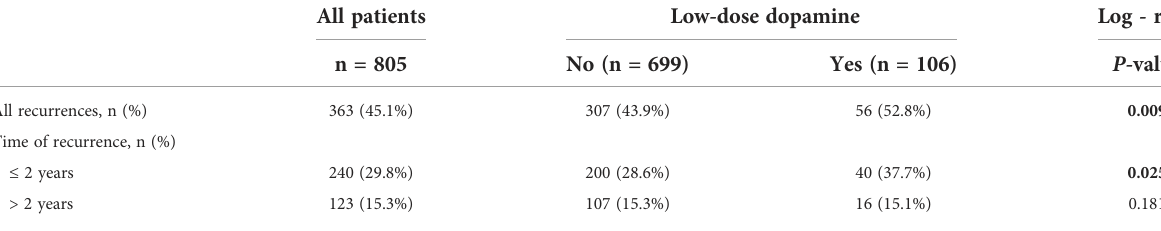
TABLE 2 Recurrence in both groups by time of recurrence before propensity score matching. All